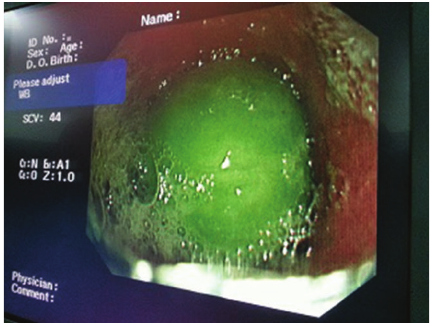
Figure 2: Gastroscopic view showing a plum causing complete obstruction.